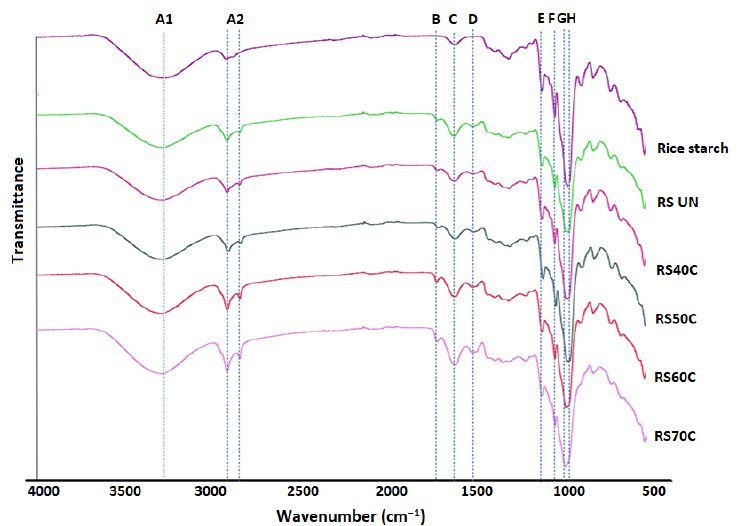
Figure 5. FT-IR spectra of native rice starch and resistant starches (RS) isolated from rice bran (RB) that was untreated (UN) and ultrasonicated (1.8 W/cm 2 , 20 min) at different temperatures.